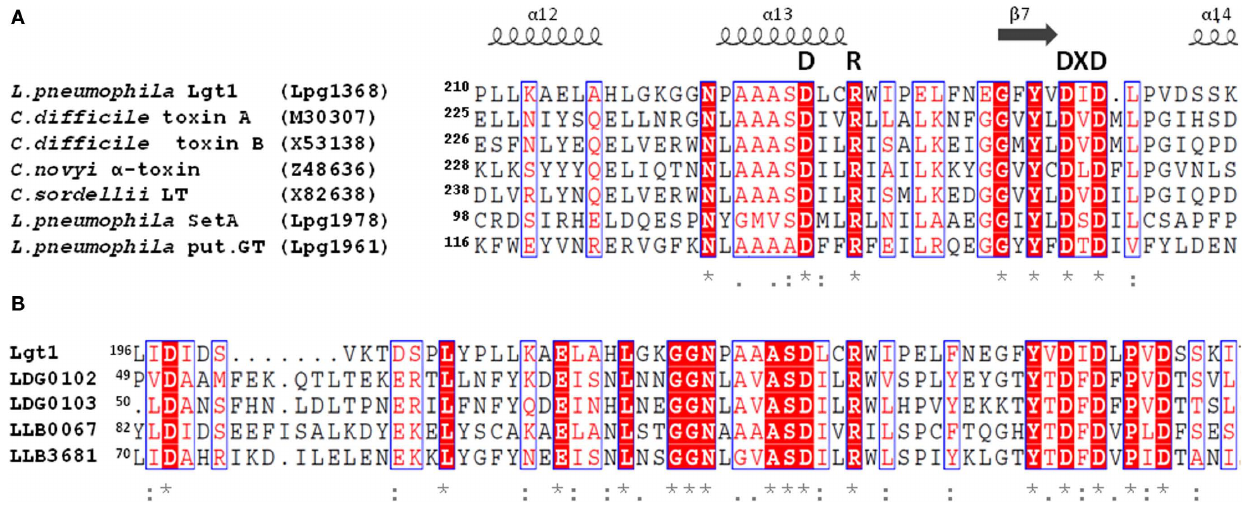
(B) Alignment of partial amino acid sequences of Lgt1 from L. pneumophila Philadelphia-1 with that of putative glycosyltransferases found in translated genomes of L. drancourtii LLAP12 and L. longbeachae D-4968. Identification codes for Lgt1 and putative glycosyltransferases in strain LLAP12 of